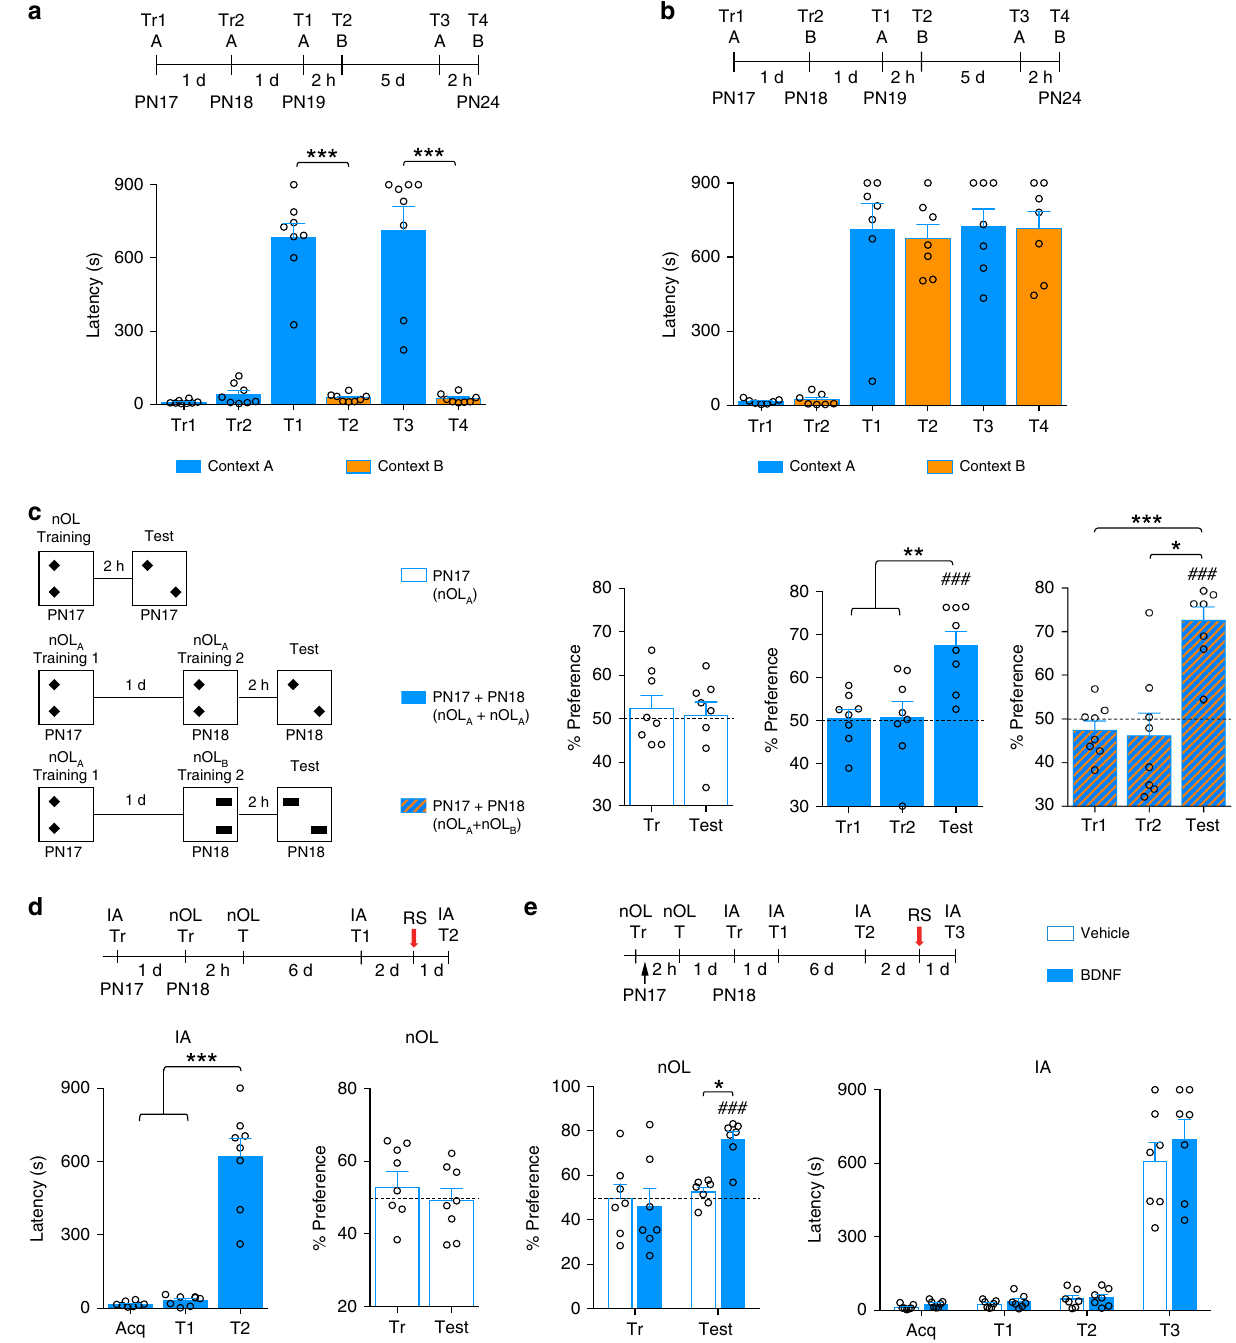
Fig. 5 Maturation of memory competence is selective for the type of learning domain. a , b Rats were trained (Tr1) in IA at PN17 in context A and retrained (Tr2) at PN18 in the same context ( n = 8) ( a ) or in a different context, context B ( n = 7) ( b ). Rats were tested 1 day later in context A (T1) and 2 h later in context B (T2). Five days later, they were again tested in context A (T3), and 2 h later in context B (T4). c Rats were trained in nOL following three schedules ( n = 8 rats per schedule): (i) one training trial (Tr) at PN17; (ii) two training trials (Tr1 and Tr2) in the same context with the same object locations spaced by 1 day (nOL A + nOL A ), or (iii) two training trials spaced by 1 day, but with the second trial presenting a different pair of objects in a different location (nOL A + nOL B ). All rats were tested 2 h after the last training (Test). d Rats ( n = 8) were trained in IA at PN17, and then trained in nOL at PN18. Rats were tested in nOL 2 h after nOL training (nOL test, T), and in IA 7 days after IA training (IA T1) then 1 day (IA T2) following the reminder shock (RS). e Rats ( n = 7 per group) were trained in nOL at PN17, bilaterally injected in the dHC with BDNF immediately after training (black arrow), and tested in nOL 2 h afterward (nOL test, T). Then, the rats were trained in IA at PN18, and tested 1 day (IA T1) and 7 days later (IA